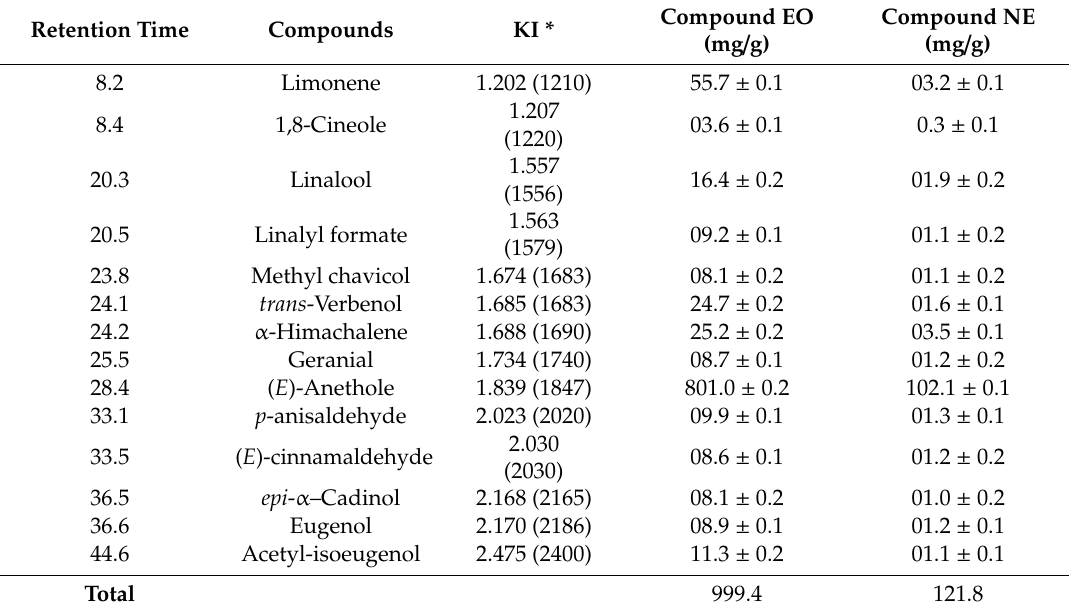
Figure 1. Structures of the main compound of the analyzed essential oil. Table 1. Chemical composition of the essential oil of Pimpinella anisum essential oil (EO) and anise nanoemulsion (NE) analyzed by GC/MS.